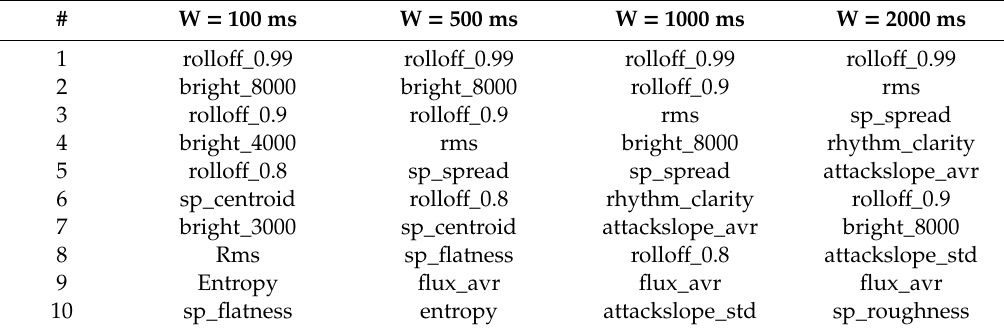
Table 4. Feature Ranking for the Language Detection (LD)